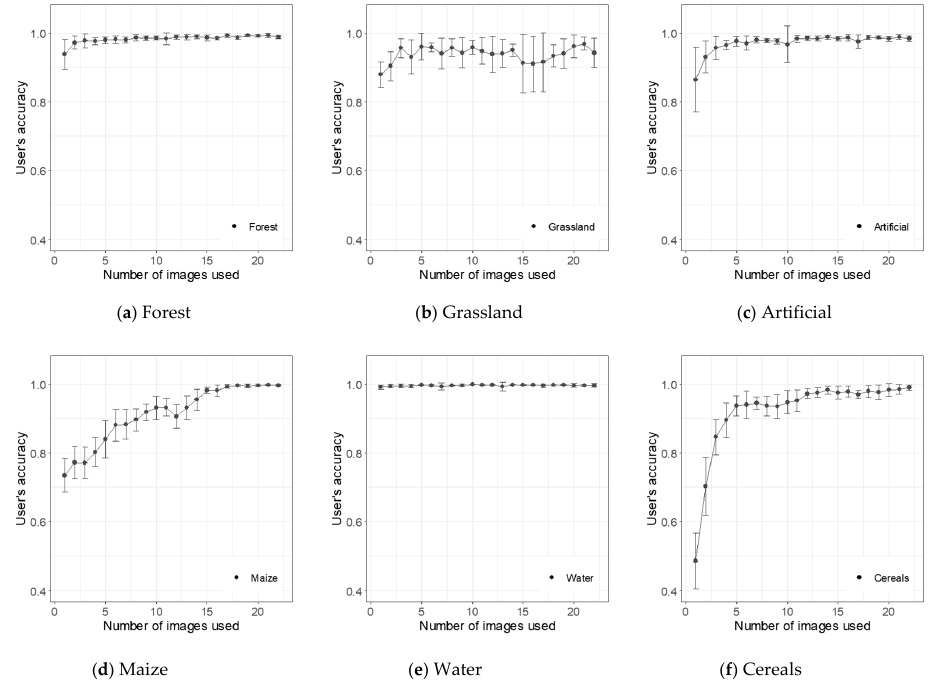
Figure 9. For Study Area 2, the mean UA of classifications (repeated at 12 segmentation scales, from scale 40 to 150) and error bars indicate the mean square errors of different segmentation scales. ( a – f ) show forest, grassland, artificial land, maize, water, and cereals, respectively.